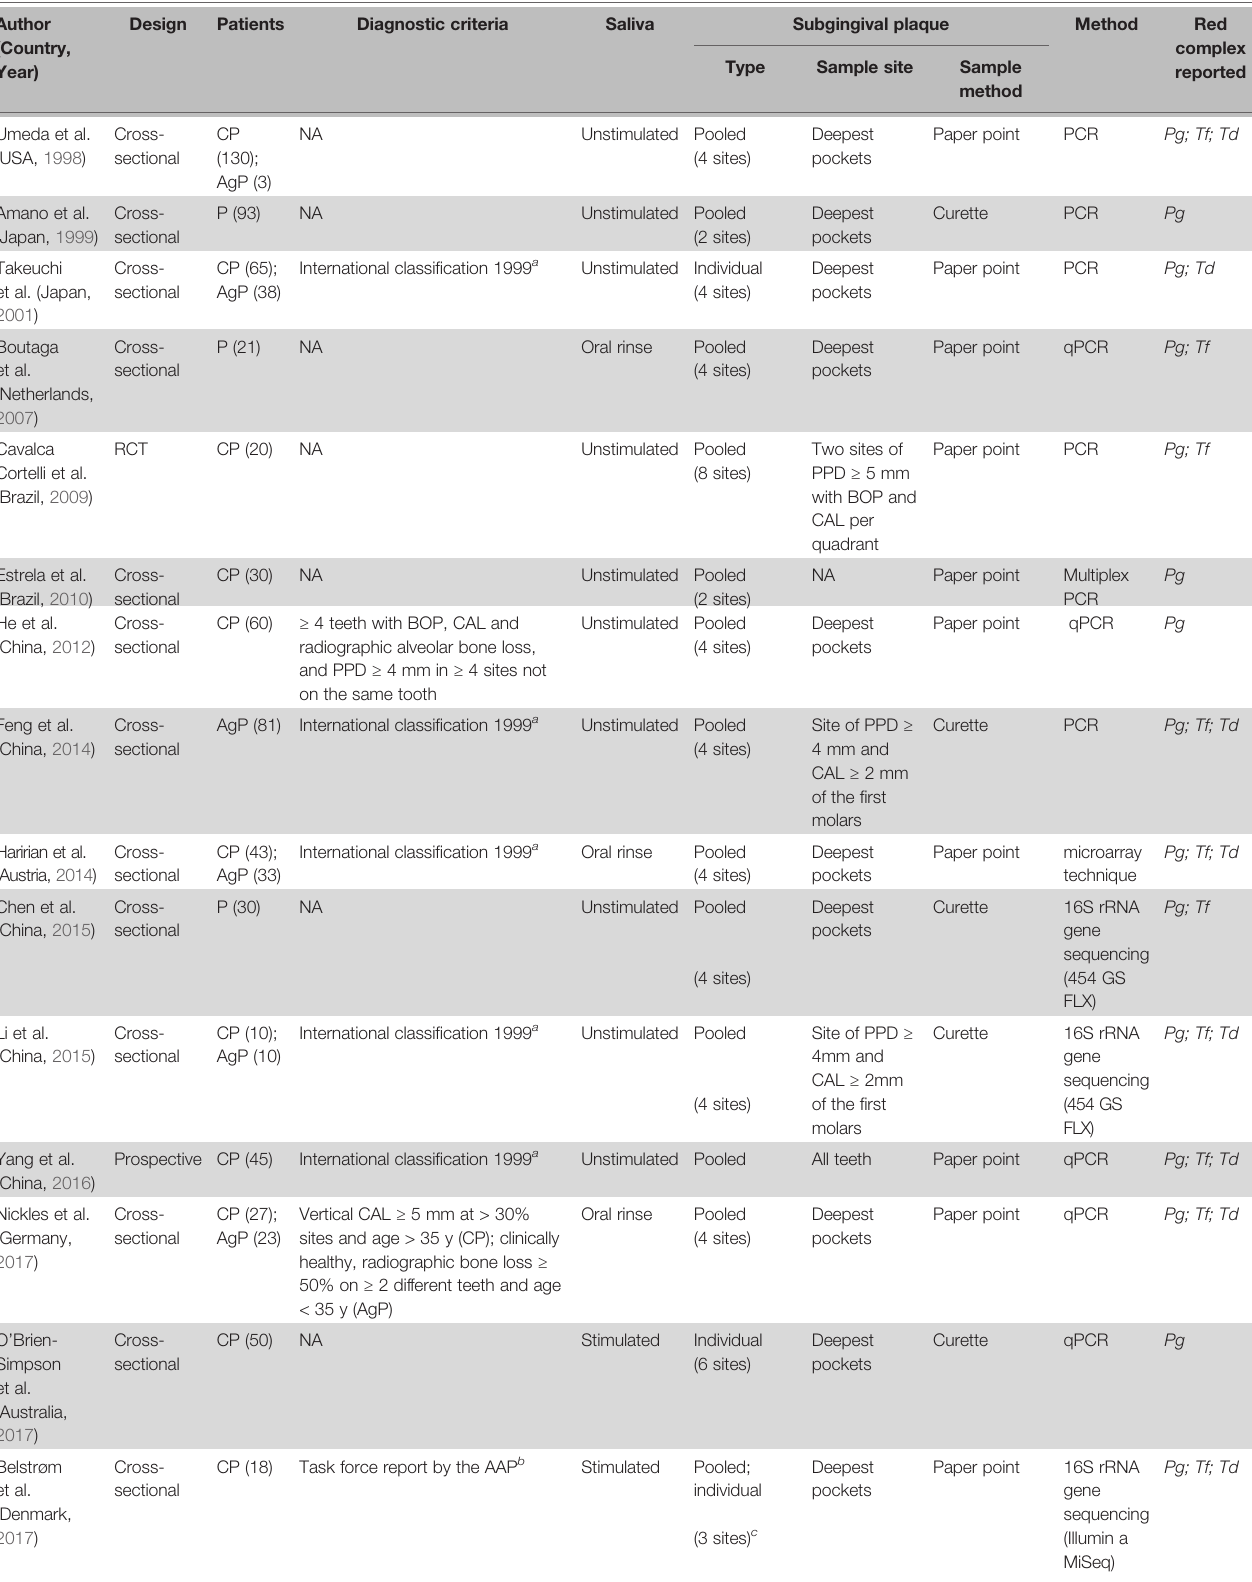
TABLE 1 | Main characteristics of all included